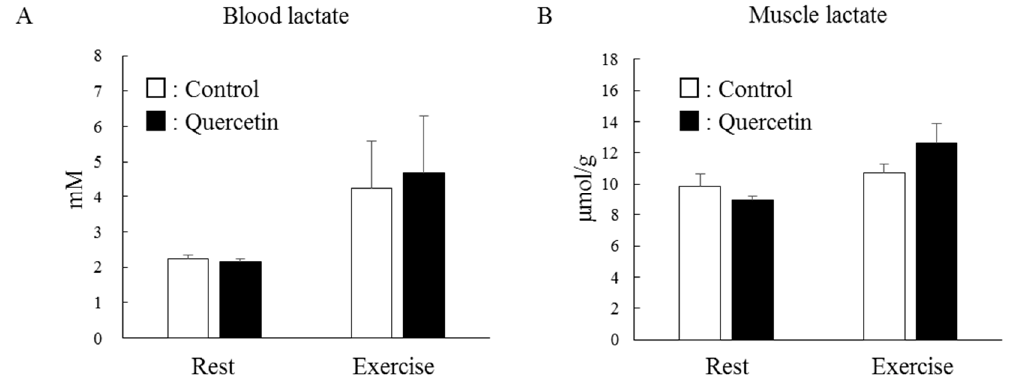
Figure 6. E ff ects of 7-day quercetin treatment on exercise-induced lactate metabolism. Rats were assigned to either a control or quercetin groups and were maintained under ad libitum feeding for 7 days. After that, rats underwent swimming exercise for 1 h. Immediately after exercise, blood was taken for blood lactate ( A ) and epitrochlearis muscles were dissected out as samples for muscle lactate ( B ). Values are means ± SE ( n = 6–7).